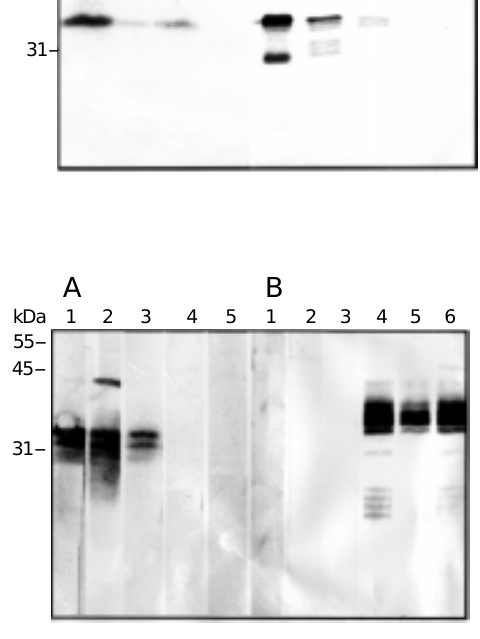
Figure 2 - A , Detection of P36 expressed in M. smegmatis. Anti-P36 was used as first anti- body. Western blot of cell ex- tracts: Lanes : 1, M. smegmatis (pMBA61); 2, M. smegmatis (pMBA62); 3, M. smegmatis (pMBA60); 4, M. smegmatis. B , Western blot of culture su- pernatants: Lanes : 1, M. bovis